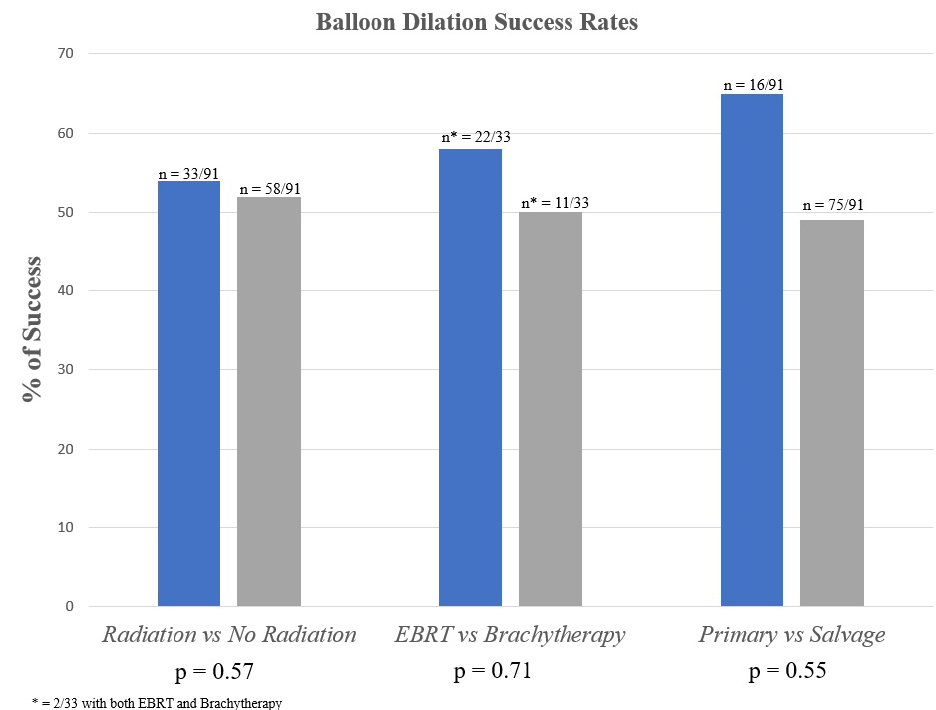
Figure 1. Balloon Dilation Success Rates .